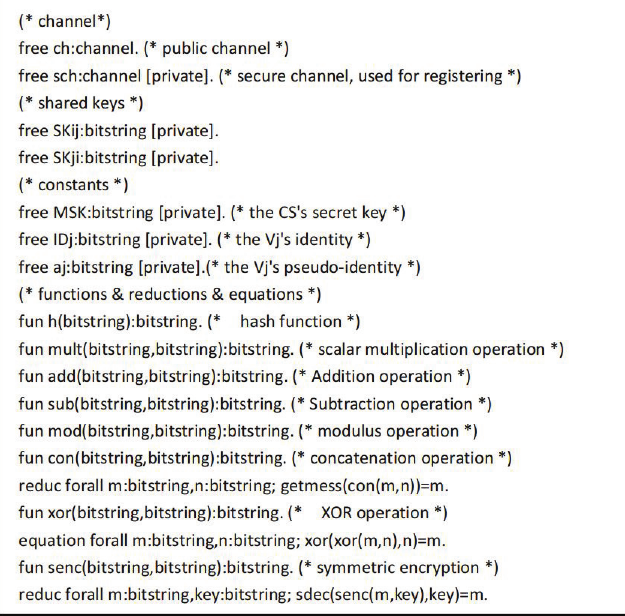
Figure 5. The definition of the proposed protocol in the ProVerif